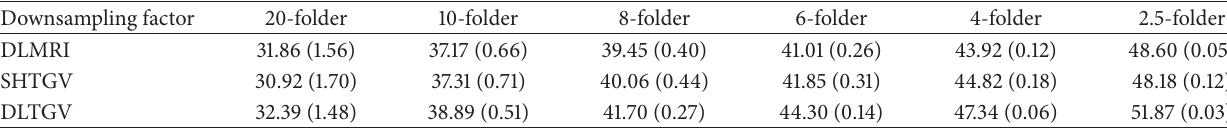
Table 1: Reconstruction PSNR (dB) and HFEN values at different undersampling factors with the same pseudo radial sampling trajectories. Downsampling factor 20-folder 10-folder